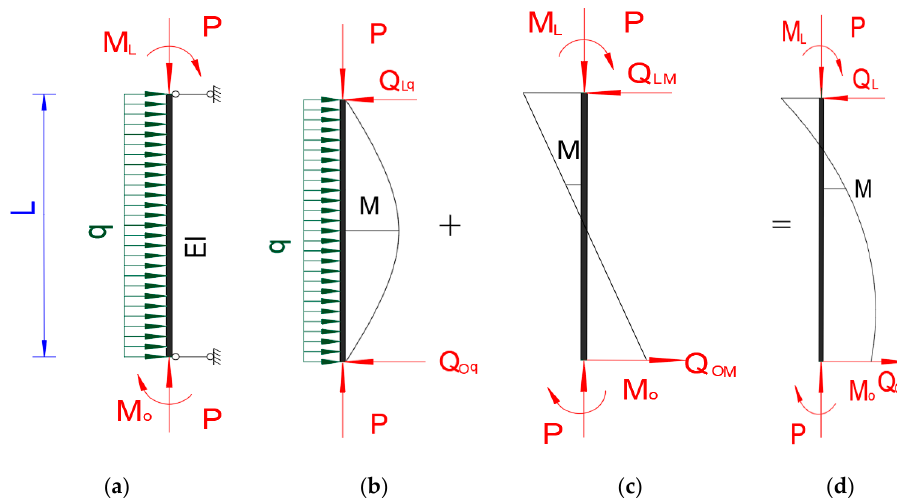
Figure 5. Schematic diagram of bending moment superposition of simply supported compression rods: ( a ) compression rod force diagram; ( b ) bending moment diagram under transverse uniform loads; ( c ) bending moment diagram under bending moments at rod ends; and ( d ) bending moment diagram of simply supported compression rods.